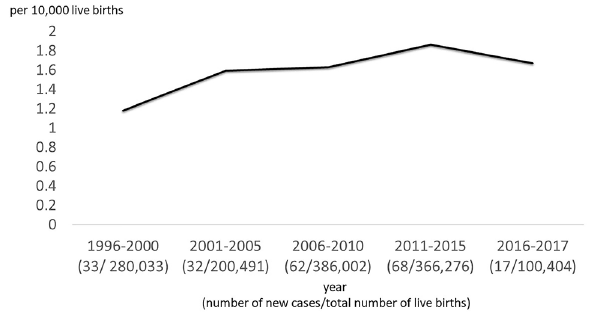
Figure 1. The incidence of BA (per 10,000 live birth) in Hong Kong from 1996 to 2017 .